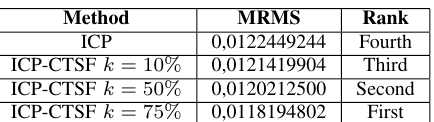
TABLE VII: Best methods, respect to MRMS, for frame-to- frame registration of video #03118 with ς = 1 and r = 8